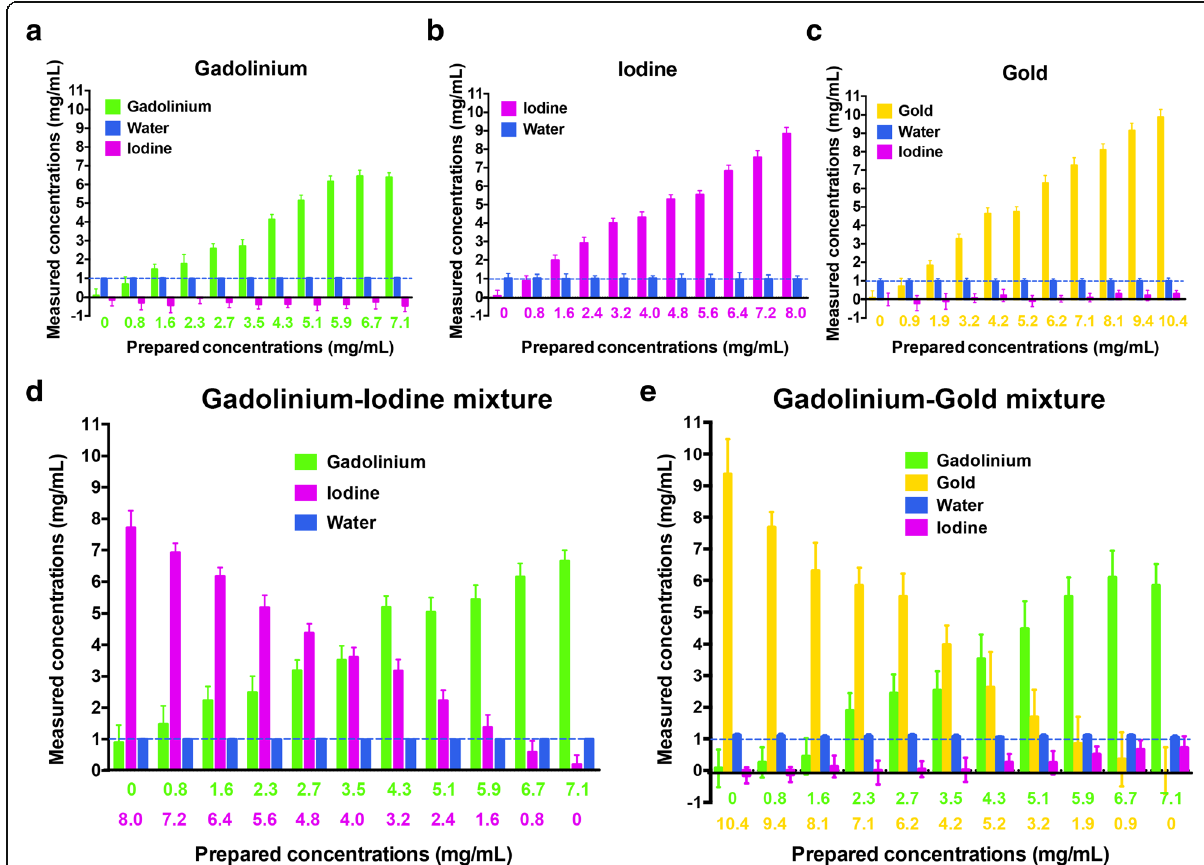
Fig. 5 Cross-contamination in the contrast agent images. The graph bars show the concentrations (mean ± standard deviation) of water ( blue ), iodine ( purple ), gadolinium ( green ) and gold ( yellow ) measured by the system, in each contrast material images, as a function of the prepared concentrations within the unmixed ( a , gadolinium; b , iodine; c , gold) and mixed ( d , gadolinium – iodine; e , gadolinium – gold) solutions. The blue dotted line represents the concentration of water expected in each solution (1000 mg/mL). Note the slight cross-contamination in the iodine image for the gadolinium – gold mixture that increases with increasing concentration of gadolinium, but not